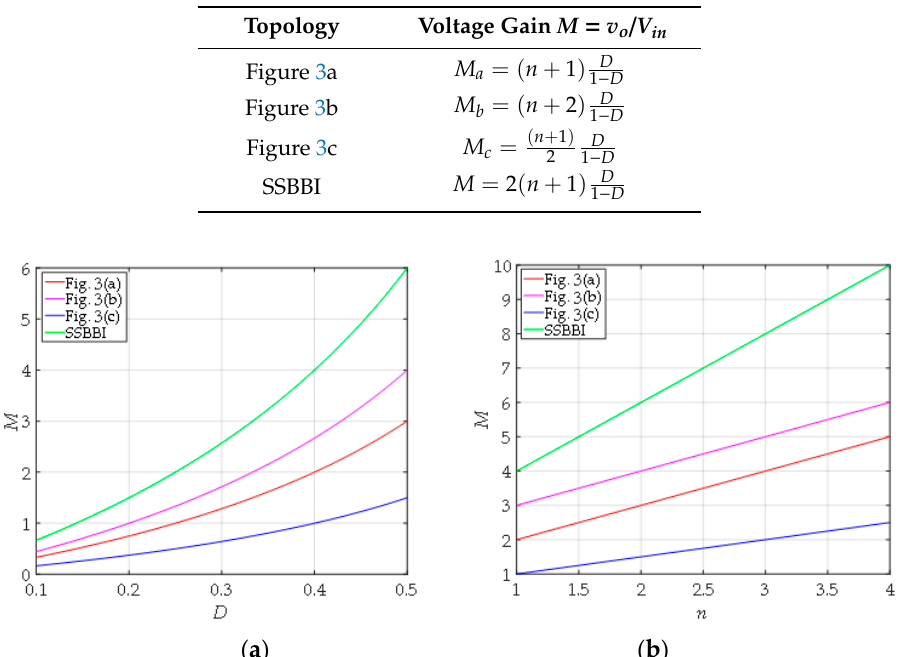
Table 5. Comparison of the voltage conversion ratio of the proposed topologies.